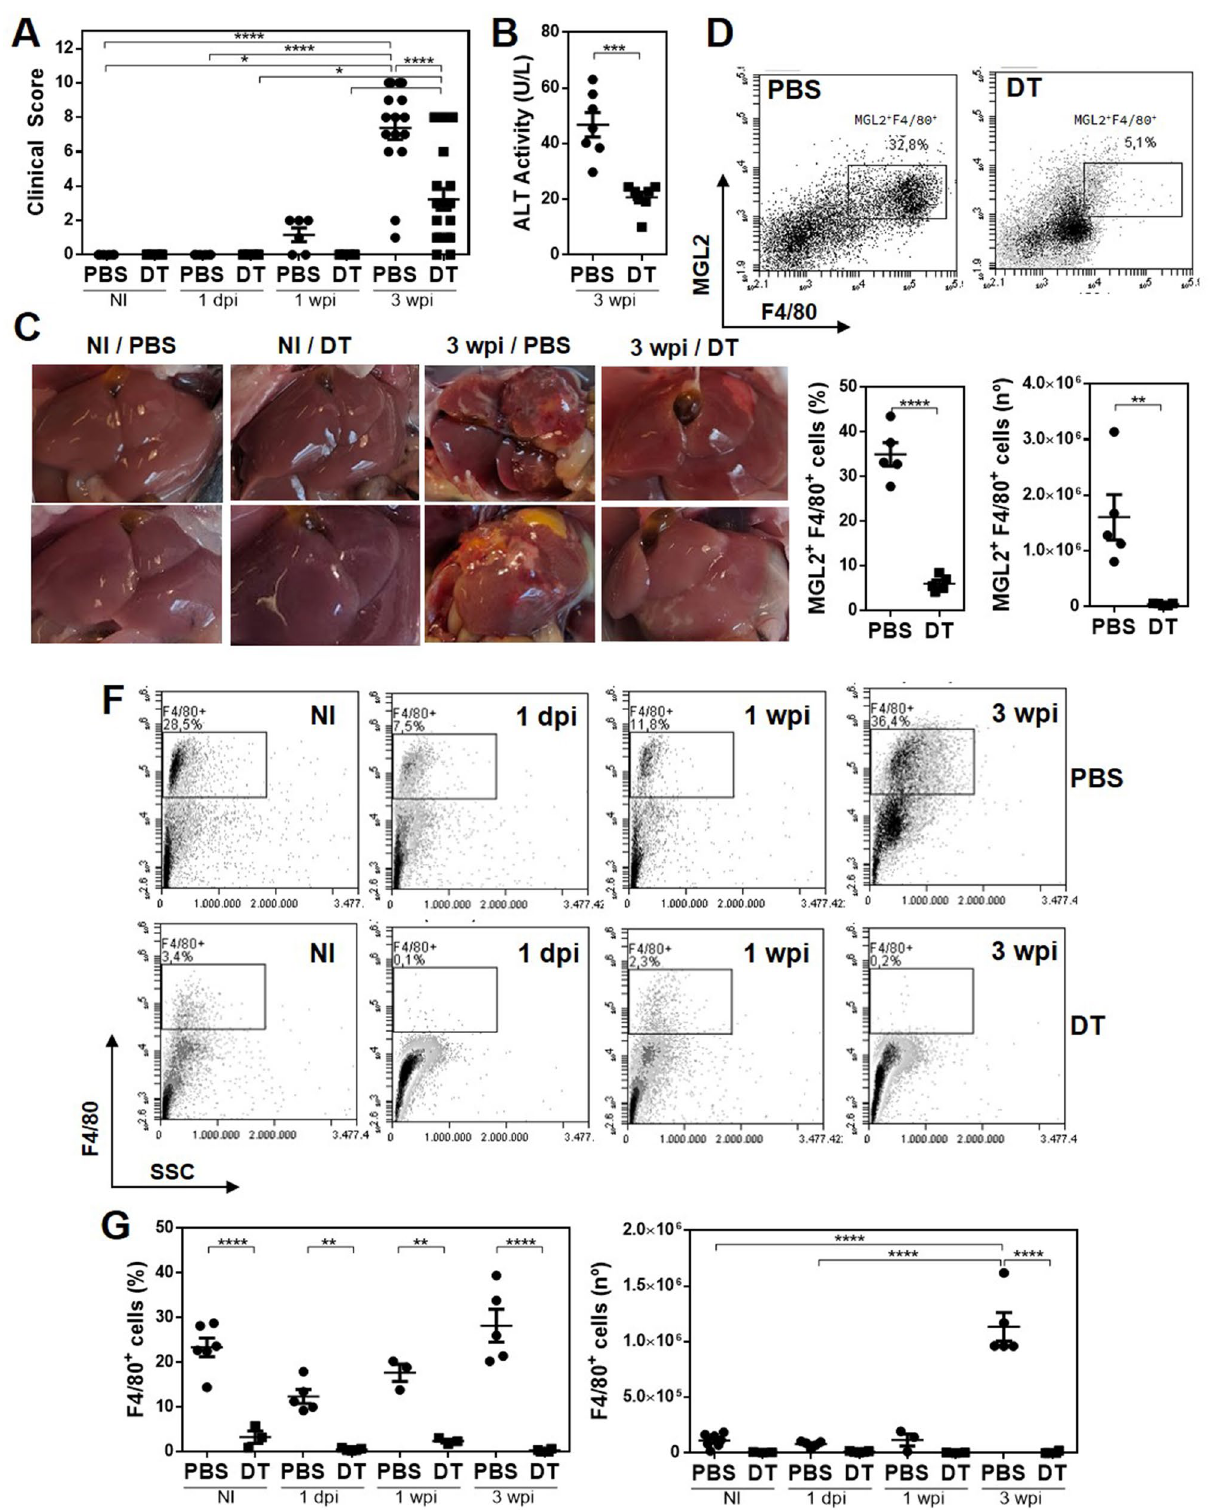
Figure 5. Depletion of F4/80 + MGL2 + cells during F. hepatica infection attenuates the clinical signs induced by the parasite. MGL2- DTR mice were infected with 10 F. hepatica metacercariae and sacrificed at 1 dpi, 1 wpi and 3 wpi. MGL2 + cells were depleted with DT-treatment. Control mice were injected with PBS. Non infected mice were used as controls (NI). Clinical score ( A ) and ALT ( B ) in serum of infected and control DT- or PBS-treated mice. ( C ) Representative images of livers from DT- or PBS-treated 3 wpi mice. ( D ) Peritoneal F4/80 + MGL2 + cells gating in F. hepatica infected mice treated with DT. ( E ) Frequency and number of MGL2 + F4/80 + peritoneal cells in infected DT- or PBS-treated mice. ( F ) Peritoneal F4/80 + cells gating during F. hepatica infection in DT-treated